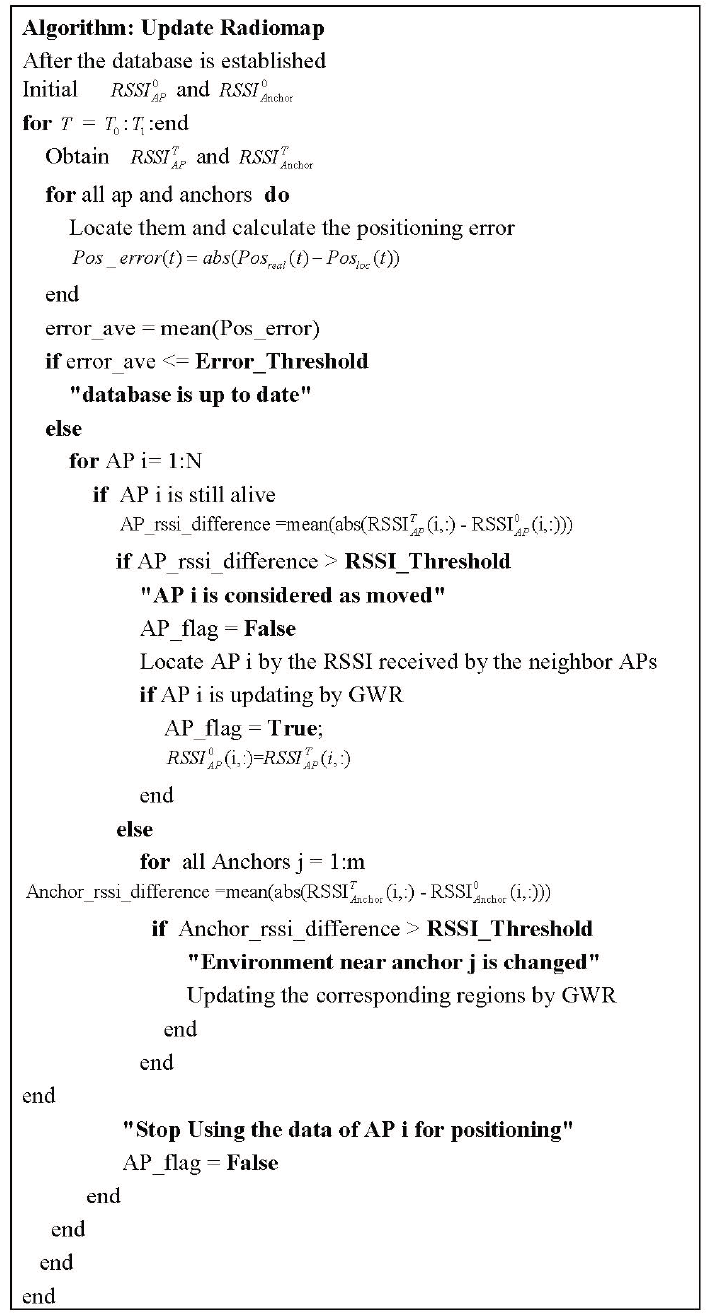
Figure 2. Pseudo-codes algorithm for updating the